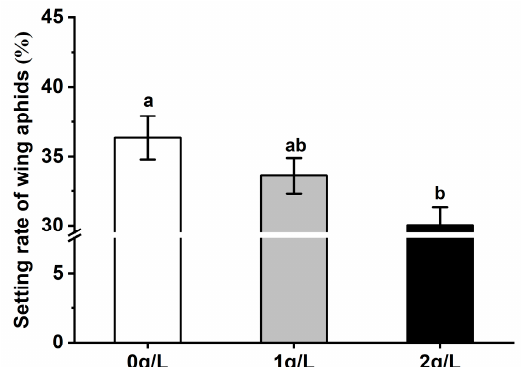
Figure 3. Effects of different silicon treatments on wheat plants’ host acceptance of winged S. avenae . Bars with different letters are significantly different (Tukey’s HSD test, p = 0.01).